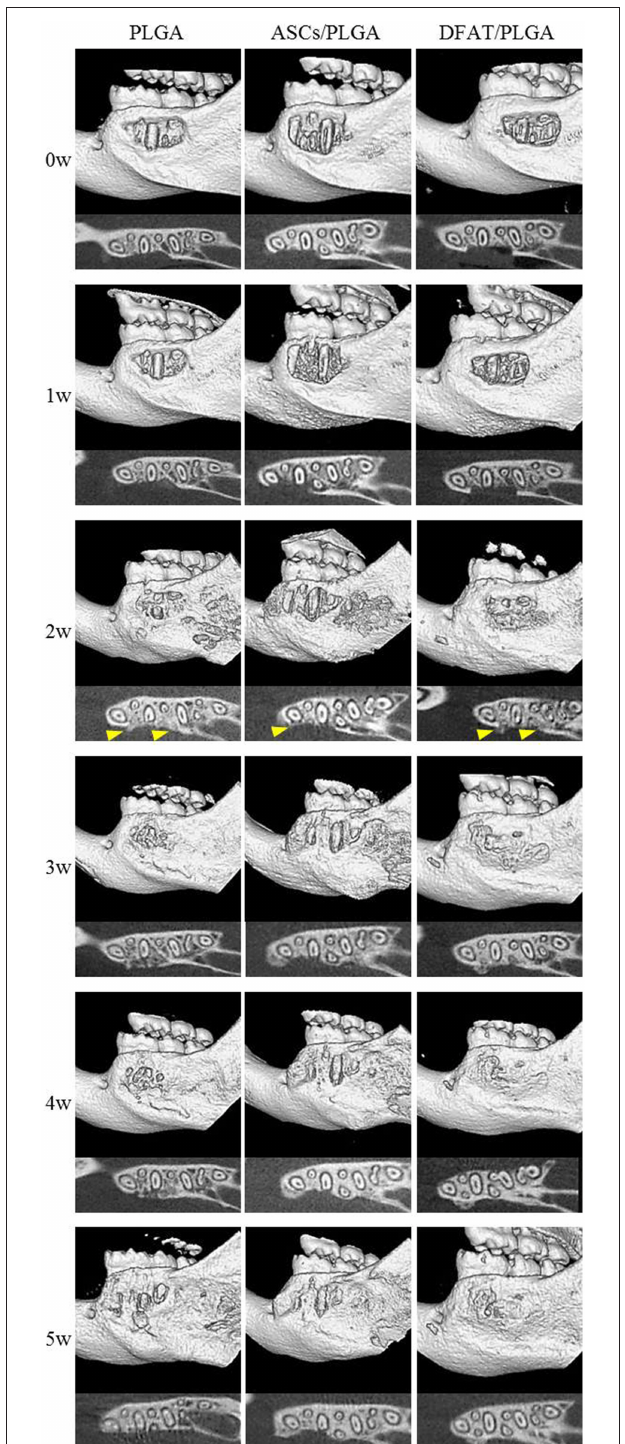
FIGURE 5 | Micro-CT images of regenerative process in the periodontal fenestration defect. Micro-CT images were obtained from the identical rats immediately after transplantation until 5 weeks after transplantation. The upper section of each image shows reconstructed micro-CT images. The lower section shows the horizontal plane section of the mandible. Hard tissue is visible (distinct from native bone structure) at 2 weeks (arrowheads).